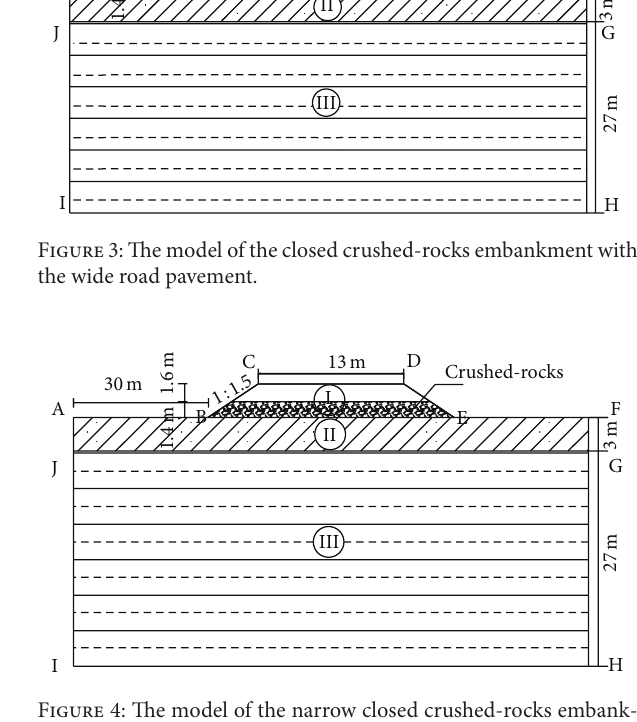
Figure 4: The model of the narrow closed crushed-rocks embank-